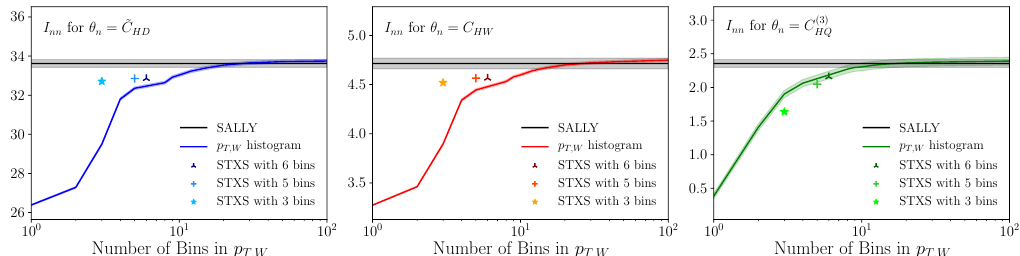
Figure 12 . Diagonal elements of Fisher information obtained from a p T;W histogram with varying number of bins. The horizontal black line shows the Fisher information obtained using the Sally method trained only with p T;W as input observable. The markers show the information in the STXS with 3, 5 and 6 bins,